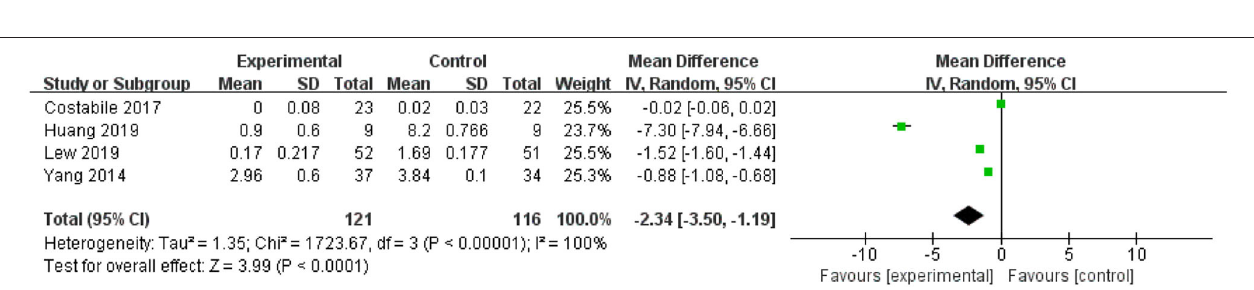
FIGURE 3 | Forest plot of effect of Lactobacillus plantarum on IL-10. SD, standard deviation; Total, sample size of each group; Mean Difference, the mean value of the experimental group minus that of the control; 95% CI, 95% confidence intervals.